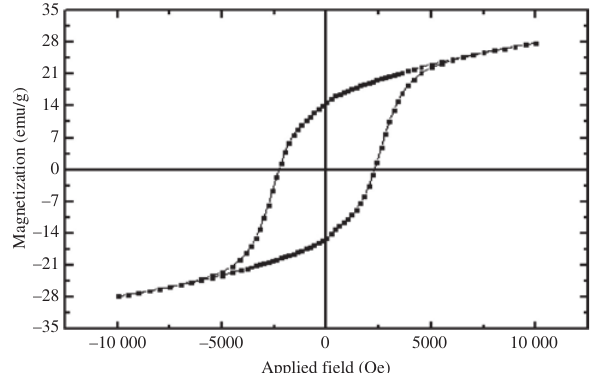
Figure 15: The VSM curves of the PbFe at 800 °